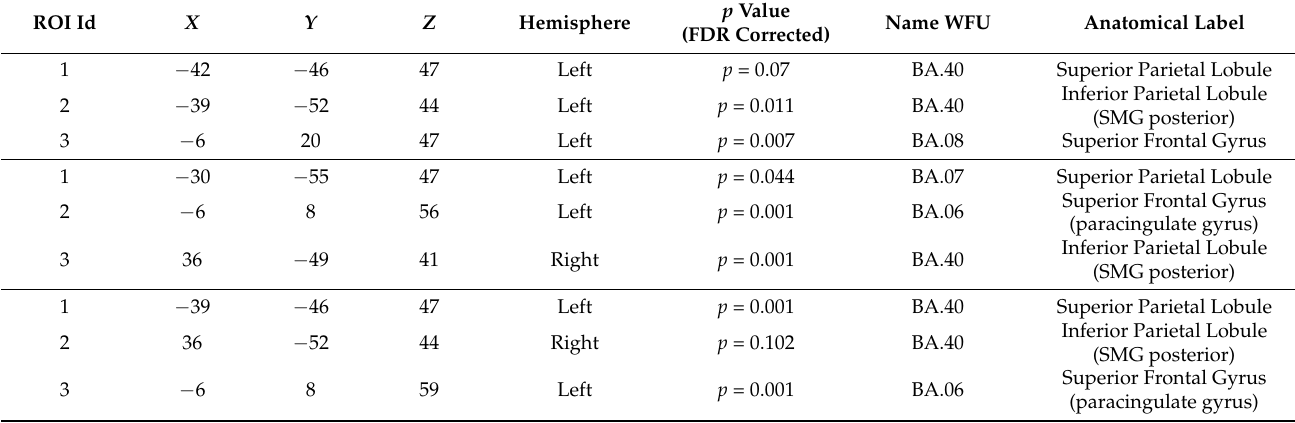
Table 2. Summary of analysis results corresponding to the significant clusters of activation for N-back task. The coordinates of the overlapping ROIs are also included, together with their anatomical label and corresponding Brodmann’s area number.